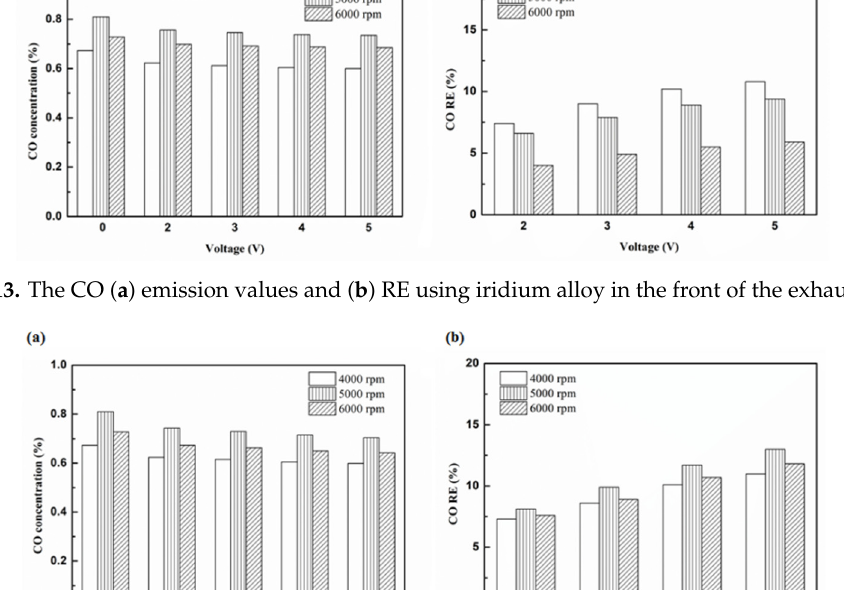
Figure 15. The CO ( a ) emission values and ( b ) RE using iridium alloy in the rear of the exhaust pipe. Figures 16–18 present the CO emission value and removal efficiency of control voltage 5 V using different materials and at various locations of the NTP reactor. Table 7 shows the maximum and minimum values of CO removal efficiency at control voltage 5 V using different materials and at various locations of the NTP reactor. The maximum CO removal efficiency was 16.0% for iridium alloy (type two) at 5000 rpm and for reactor in the rear of the exhaust system (model B). The minimum CO removal efficiency was 3.3% for platinum (type one) at 6000 rpm and for reactor in the front of the exhaust system (model A). The NTP reactor material of types one and type two reduced the CO exhaust gas concentration. The effect of type two NTP reactor material was found to be better than that of type one because, low resistance forms larger spark and high internal density. The production of free radicals increases by increasing the spark size. The larger amount of radicals and higher combustion reaction temperature caused an increase in the dissociation probability of CO exhaust gas. The dissociation of CO is broadly divided into two parts. In the first part, the dissociation of CO gives carbon and oxygen atoms. Carbon atoms get deposited on the surface of the NTP reactor, as shown in Figure 19. The second part involves the recombination of CO and oxygen atoms to form the CO 2 . The location of the NTP reactor in models A and B reduce the CO exhaust gas concentration. In model A, the CO removal efficiency increased with a decrease in the engine speed, which caused the flow rate of exhaust gas to be slow. The dissociation probability of CO exhaust gas increased with the increase in contact time between the spark and CO exhaust gas. The CO removal efficiency was the highest in model B at 5000 rpm because the flow rate of exhaust gas was almost the same in model B. The dissociation probability of CO exhaust gas increased with an increase in CO gas flow per unit area. The reduction in CO removal efficiency of model B is higher than that of model A. This is because in model B, the dissociation of free radical and CO exhaust gas has a larger space, and the flow rate of exhaust gas was slow. This reduced the CO exhaust gas emissions. However, the amount of change in the CO exhaust gas measurement is small, there may be random errors in this experiment which may be caused by ambient temperature, humidity and dust. The random errors of CO exhaust values is about 0.1.